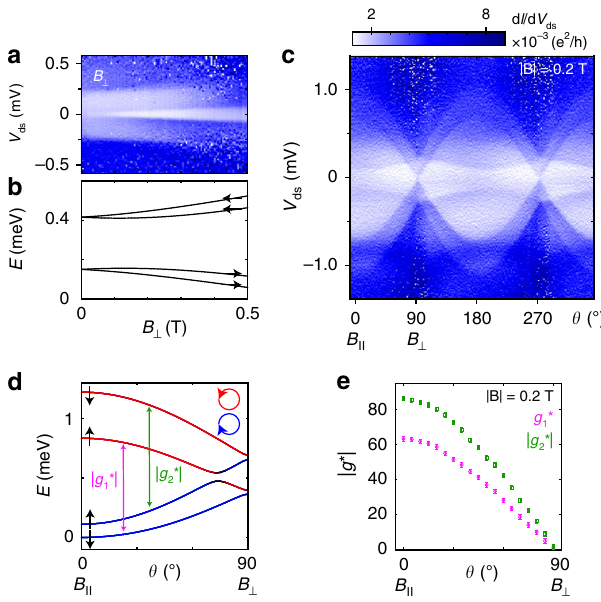
Fig. 3 1e regime at zero detuning for different B- fi eld directions. a Measurement of d I /d V ds versus V ds and B ⊥ . b Numerical calculation of the state energies as functions of B ⊥ . The spin arrows indicate the alignment of the spin with respect to the external B - fi eld. c , d Measurement of d I /d V ds and numerical calculation as a function of B - fi eld direction for | B | = 0.2 T. The colour represents the calculated orbital angular momentum (blue: L z , = − 1.3 ħ , black: L z , = 0, red: L z , = 1.3 ħ ).The strong orientation dependence is a result of the orbital contribution to g *. e Experimental values of | g 1 *| and | g 2 *| as functions of B - fi eld direction. The error bars represent the uncertainty in energy gap extraction due to measurement noise and